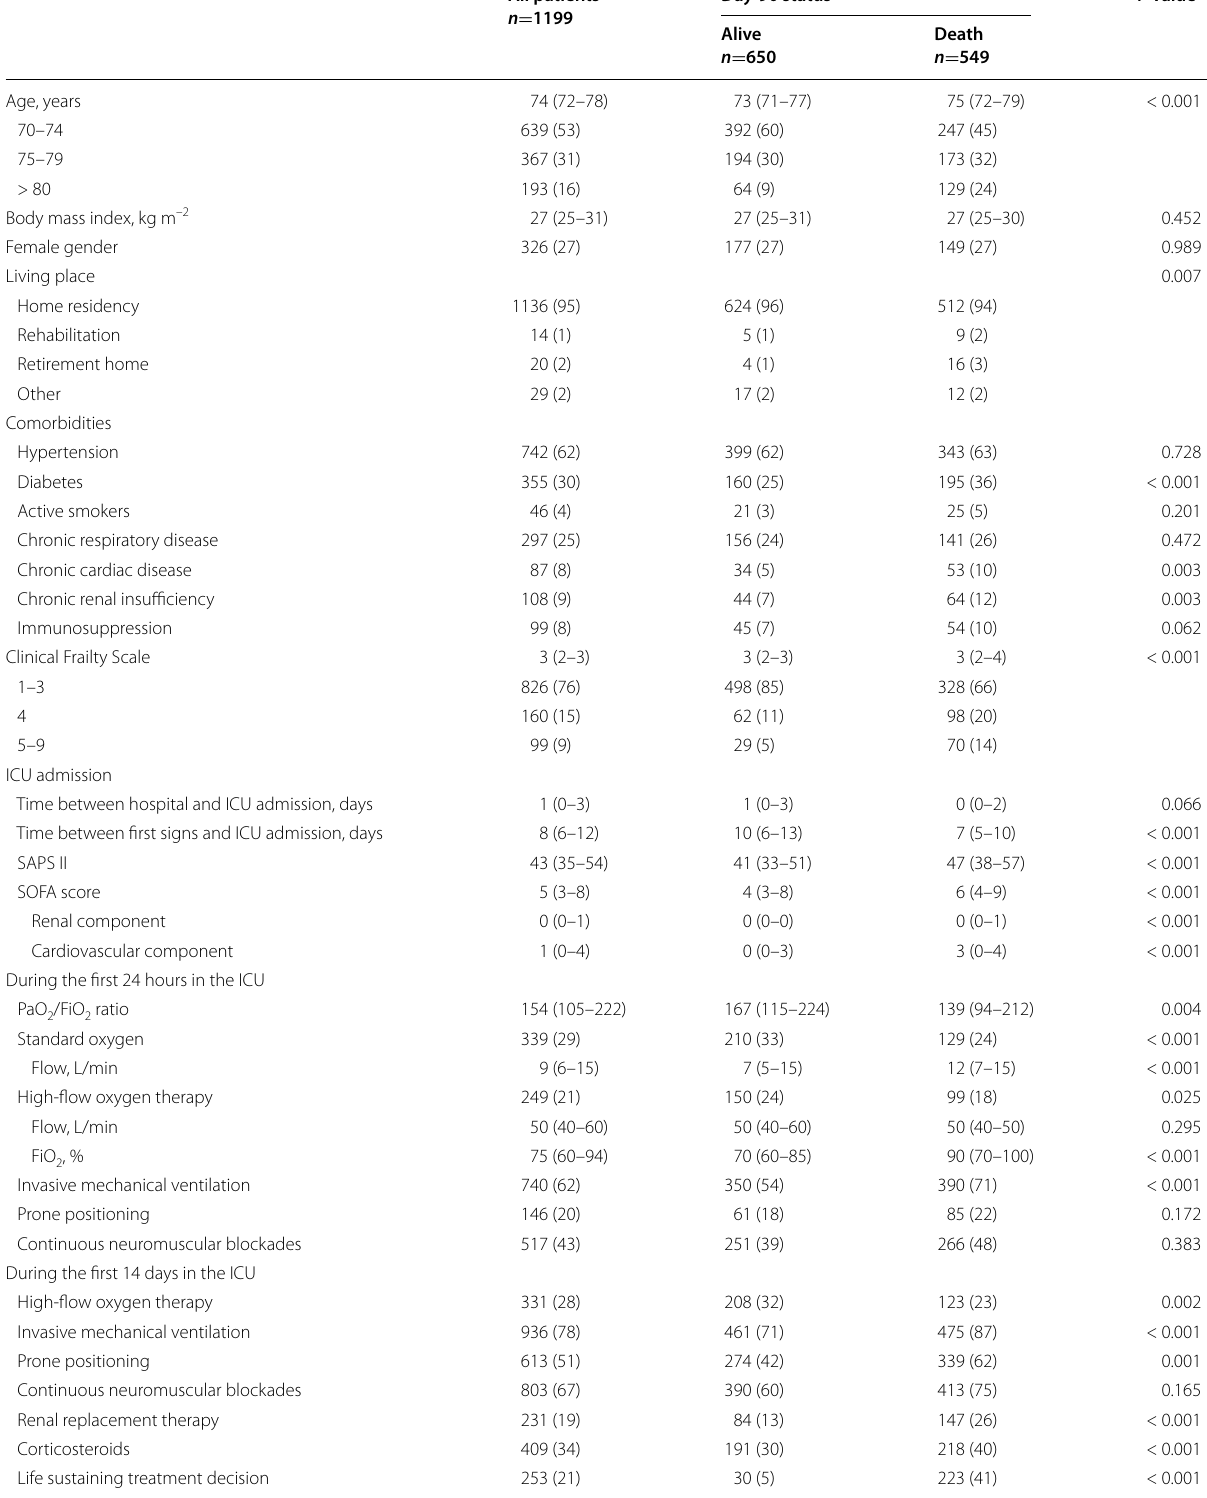
Table 1 Demographic characteristics and management during the first 14 days of ICU according to their Day-90 survival